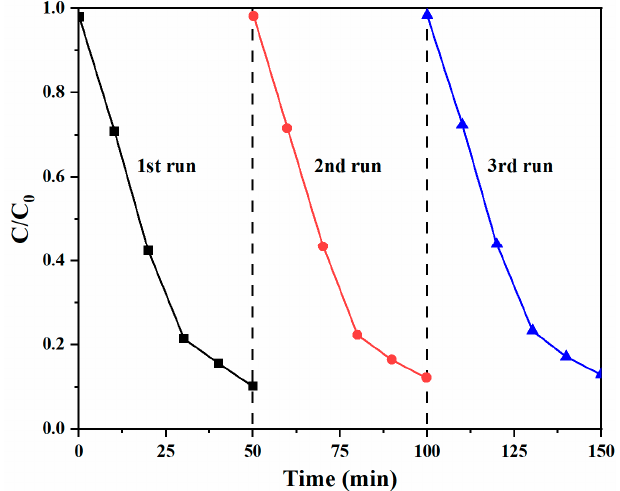
Figure 8. Recycling performance of the ZnS/Ag 2 O composite for degrading MB.